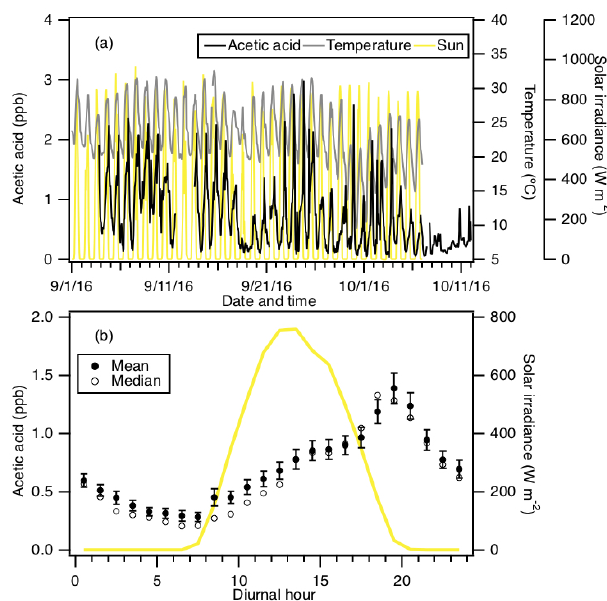
Figure 4. (a) Time series of acetic acid concentration, tempera- ture and solar irradiance. All the data are displayed as 1h averages. (b) Diurnal profiles of acetic acid (symbols) and solar irradiance (yellow line). All the concentrations represent averages in 1h inter- vals and the standard errors are plotted as error